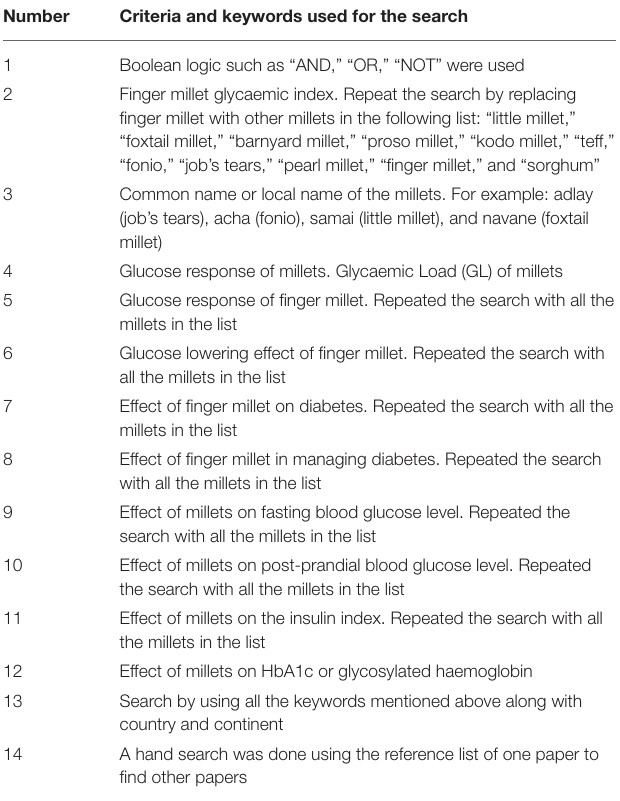
TABLE 1 | Search strategy and keywords used to identify the relevant papers.